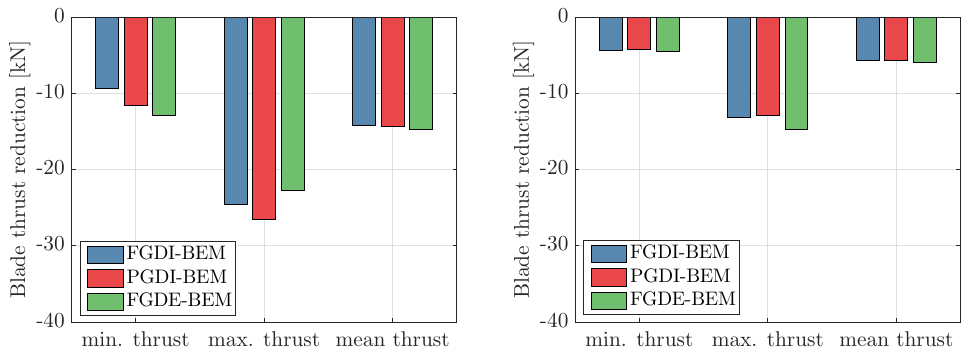
Figure 16. Thrust reduction for minimum, maximum and average blade thrust calculated for the glass–epoxy ( left graph ) and the carbon–epoxy ( right graph ) propeller as obtained from the BEM-FEM coupled